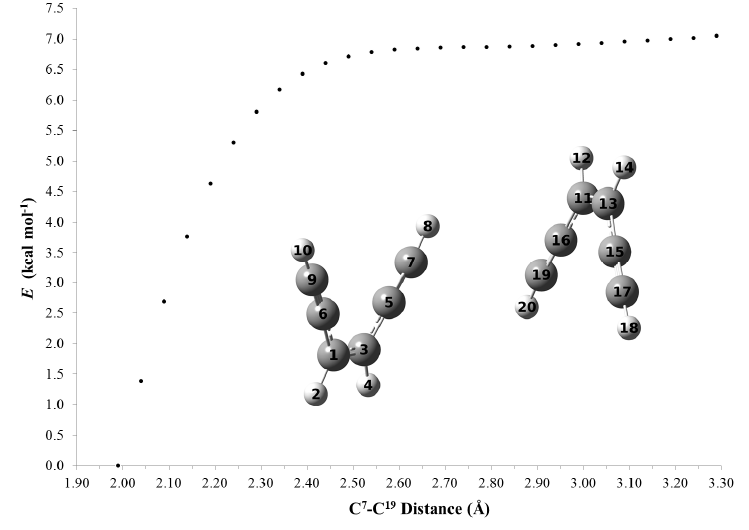
Figure 6. Analysis of the bond formation between C 7 and C 19 by performing the relaxed scan method at UBLYP/6-31+G(d) level on the reaction of 9 +• ( left ) and the neutral 9 ( right ) molecule (Relative energies are in kcal·mol − 1 and distances are given in